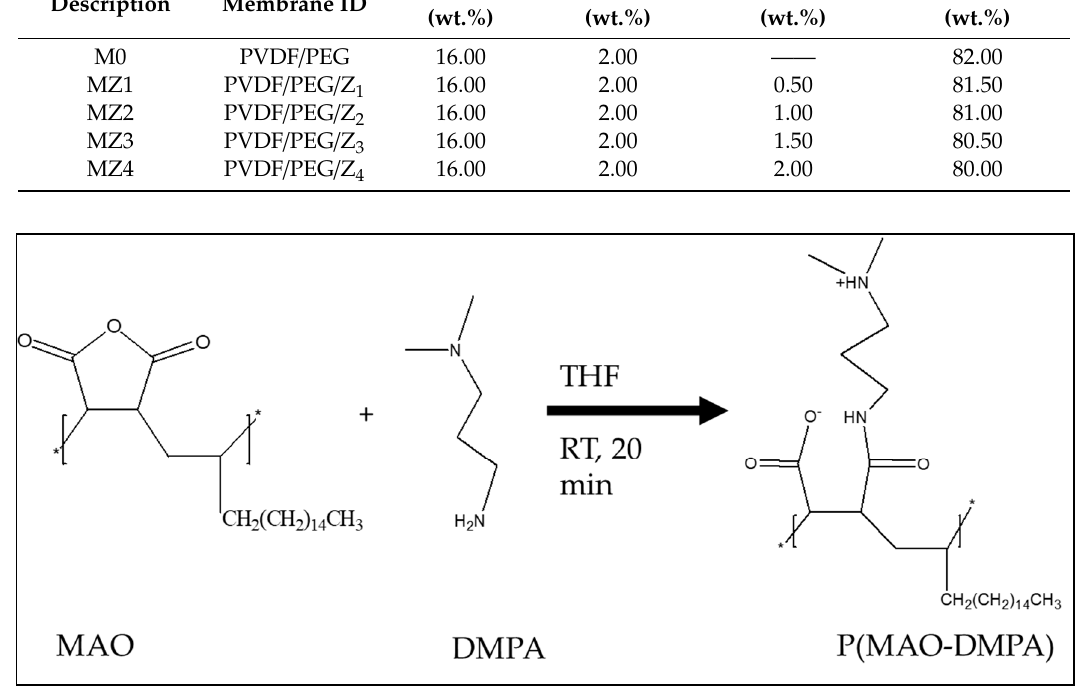
Figure 1. Synthesis of p(MAO-DMPA) by ring-opening reaction [23]. RT: room